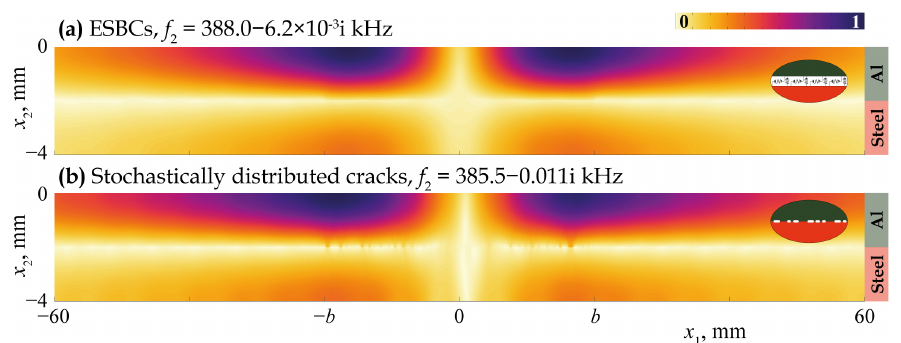
Figure 12. Eigenforms | u | ( x 1 , x 2 ) related to eigenfrequencies f 2 for a uniform partially closed delami- nation of length w = 40 mm with the crack density C = 0.5 modelled as an array stochastically ( b ) and via the ESBCs ( a